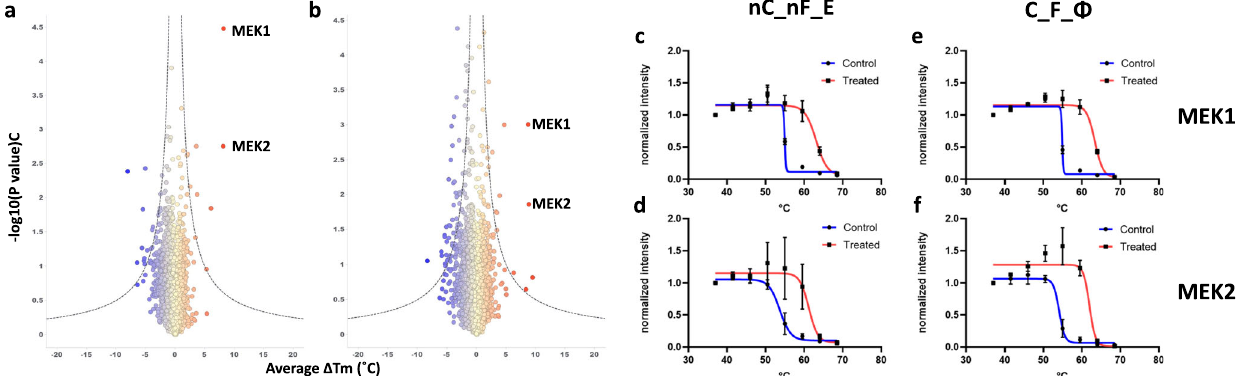
Fig. 6 MEK targets identi fi ed as having signi fi cantly shifted T m in a fractionation experiment. Volcano plots for a C_F_ Φ and b nC_nF_E indicate MEK1 and MEK2 were the most signi fi cantly stabilized protein by each iMAATSA. Melting-curves with error bars ( n = 3) for nC_nF_E of c MEK1 and d MEK2. Melting-curves for C_F_ Φ of e MEK1 and f MEK2. The data points represent the results of replicate experiments ( n = 3) for a , b . The error bars represent the standard deviation ( n = 3) for c –